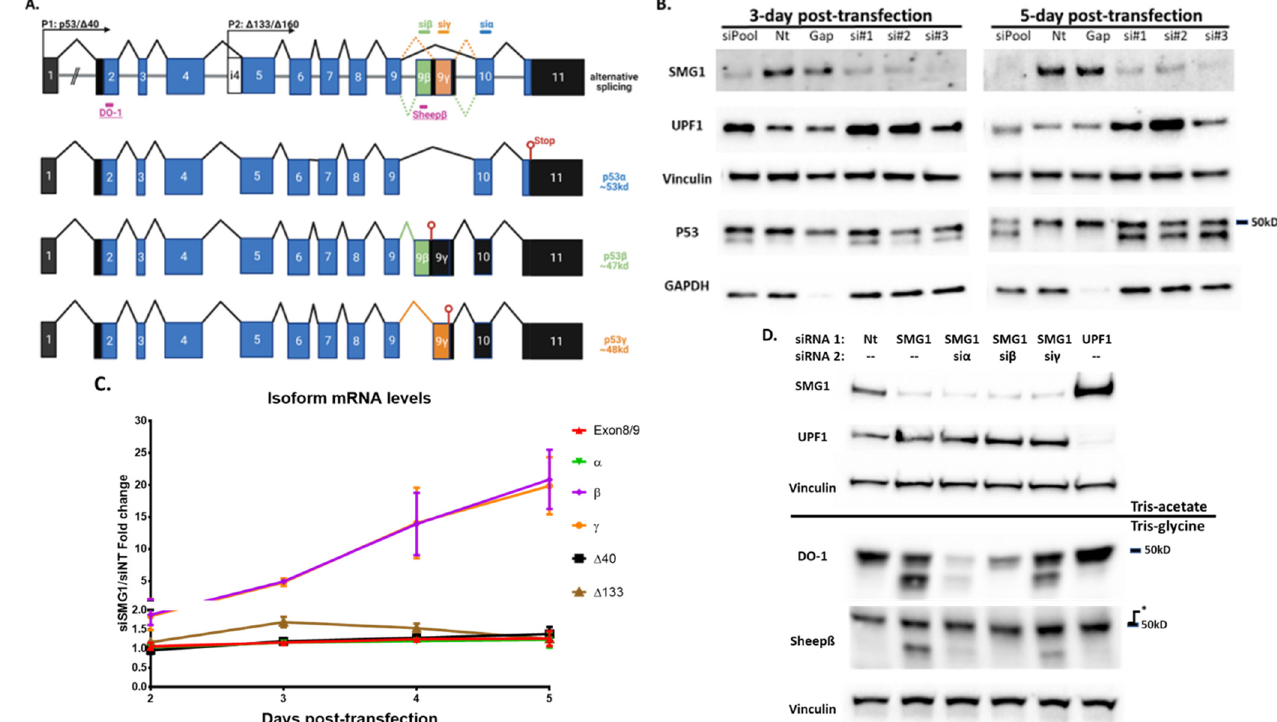
Figure 2. SMG1 knockdown induces p53 β isoform. ( A ) Top: Schema depicting p53 alternative splicing isoforms, siRNA target exons and epitopes of p53 antibodies. Bottom: three mRNAs represent three types of C-terminus variants. Created with Biorender.com. ( B ) Proteins of p53 and p53 isoforms detected with DO-1 antibody in MCF7 p53 +/+ cells 3 and 5 days after transfection with siRNAs. siPool and Gap, Dharmacon TM ON-TARGETPlus validated 4-siRNA pool targeting SMG1 and GAPDH, respectively. NT is a 4-siRNA pool of no-target control siRNAs from the same vendor. si#1and si#2 are Silencer TM select validated SMG1 siRNAs and si#3 is a 1:1 mix of si#1 and si#2. All other experiments utilized the si#3 mixture with the highest knockdown efficiency. Vinculin is the loading control. ( C ) RT-PCR analysis of p53 isoform mRNA expression in MCF7 cells following transfection with siSMG1 or siNT at 48-, 72-, 96-, and 120 h. Cells were harvested, and RNA collected at indicated times post-transfection. Taqman primers were specific to N-term variants ( Δ 40 or Δ 133 ) or C-term variants ( α , β or γ ) or total spliced p53 (Exon8/9). The results of three separate experiments (duplicated or triplicated each) are summarized. Results for siSMG1 are normalized to siNT. ( D ) p53 isoform protein expression by Western blot 5 days post transfection of MCF7 cells with siRNA combinations. Results for p53 antibody DO-1 (recognizes amino acids 20-25 in exon 2) and a Sheep- host β specific antibody (recognizes amino acids peptide TLQDQTSFQKENC in exon 9 β ; see Ap- pendix S2) are shown. *Asterisk indicates a known cross reactivity band that is unaffected by any p53 siRNA. Si α targets p53 mRNA exon 10, which is common in all isoforms, and mainly silences p53 α ; si β and si γ targets β / γ specific c-termini, respectively (see Supplemental List S2 for se- quences). *Asterisk indicates a known cross reactivity band that is unaffected by any p53 siRNA. Two types of electrophoresis gels, tris-acetate and tris-glycine were used to achieve best separation based on protein MW (see Methods 2.3 for details). Error bars represent Mean ± SD. For all RT-PCR studies, individual samples are run in triplicate. Original Western blots, view Supplemental Figures. 3.3. P53 Isoforms Modulate the Expression of ABCA1 Differently with No Effects on SREBP2 or MVD Lacking a clear mechanism for SMG1 inhibition to increase both ABCA1 expression and MVA synthesis genes, and with published studies supporting p53’s non-canonical ef- fects on lipid and cholesterol metabolisms [39,40], including the findings from the Prives’ laboratory for a ‘p53-ABCA1-SREBP2’ metabolic axis [26], we asked if SMG1 knockdown effects on p53 isoform expression could explain any of our results. After demonstrating that SMG1 inhibition leads to an increase in p53 alternative splicing, we co-transfected MCF7